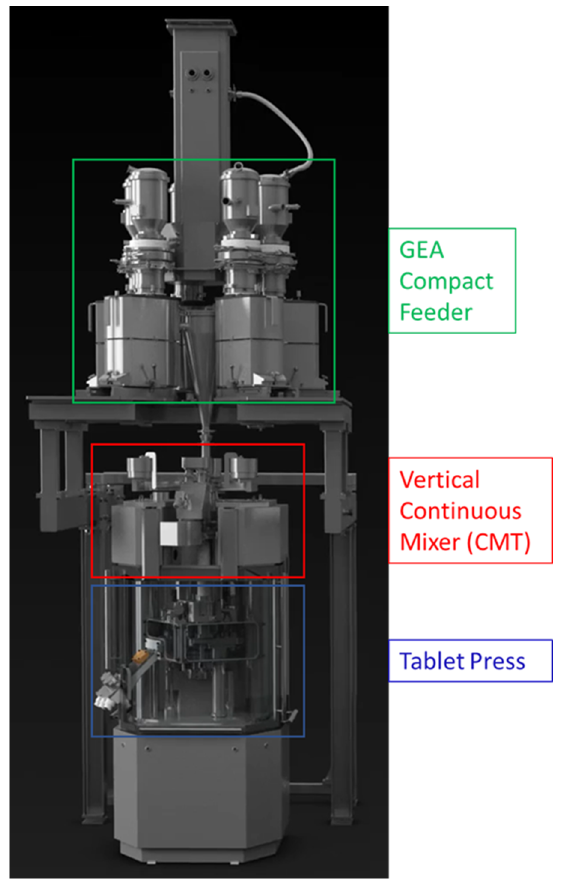
Figure 1. Overview of the direct compression line used for this trial.